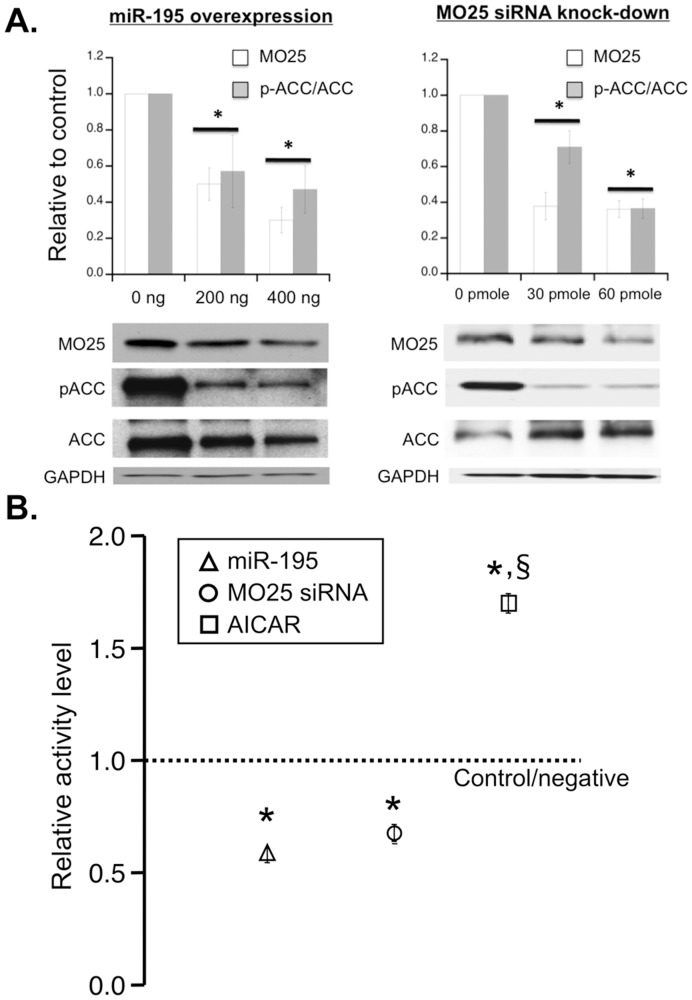
MO25 expression and downstream AMPK signaling in C2C12 cells.
A, Left panel: Bar graph summary (top panel) of Western blots (bottom panel) for MO25, acetyl CoA carboxylase (ACC) and phosphorylated ACC (p-ACC) in C2C12 cells transfected with either 0 ng, 200ng or 400ng of miR-195 overexpression constructs. Each bar indicates mean values ± S.E.M. of 3 separate experiments and represents the ratio of total protein to GAPDH or phosphorylated protein to each respective level of total protein following normalization to GAPDH. *P<0.05 compared to 0 ng C2C12 cell group. A, Right panel: Bar graph summary (top panel) of Western blots (bottom panel) for MO25, acetyl CoA carboxylase (ACC) and phosphorylated ACC (p-ACC) in C2C12 cells treated with Stealth RNAi siRNA for miR-195 using HiPerfect reagent. AllStars Negative Control siRNA was used as negative control. Each bar indicates mean values ± S.E.M. of 3 separate experiments and represents the ratio of total protein to GAPDH or phosphorylated protein to each respective level of total protein following normalization to GAPDH. *P<0.05 compared to control group. B: miR-195 overexpression and MO25 siRNA knock-down significantly decreased AMPK activities in direct AMPK Kinase assay (Cyclex), While AICAR increased AMPK activities. Each plot indicates mean values ± S.E.M. of 3 separate experiments. *P<0.05 compared to control group; § P<0.05 compared to miR-195 or siRNA knock-down group.